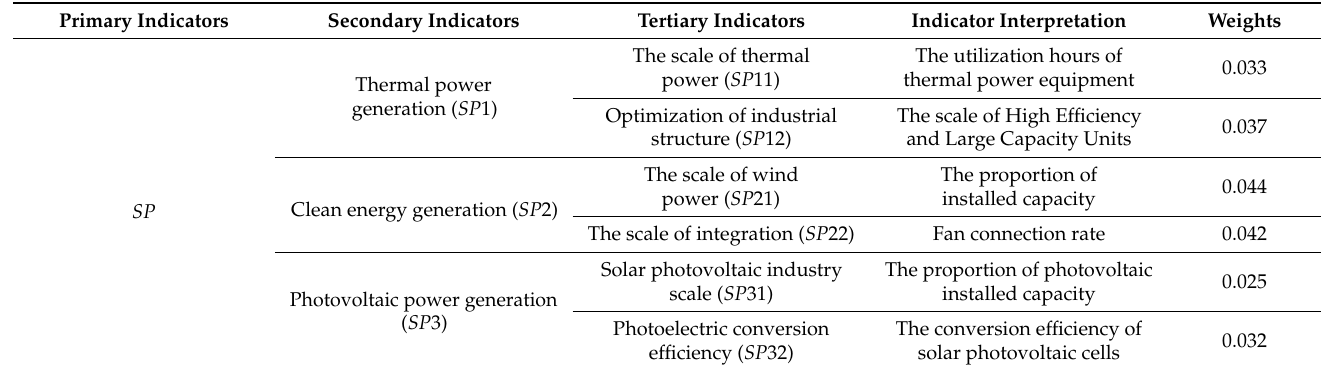
Table 4. Evaluation index system of the low-carbon level of the power